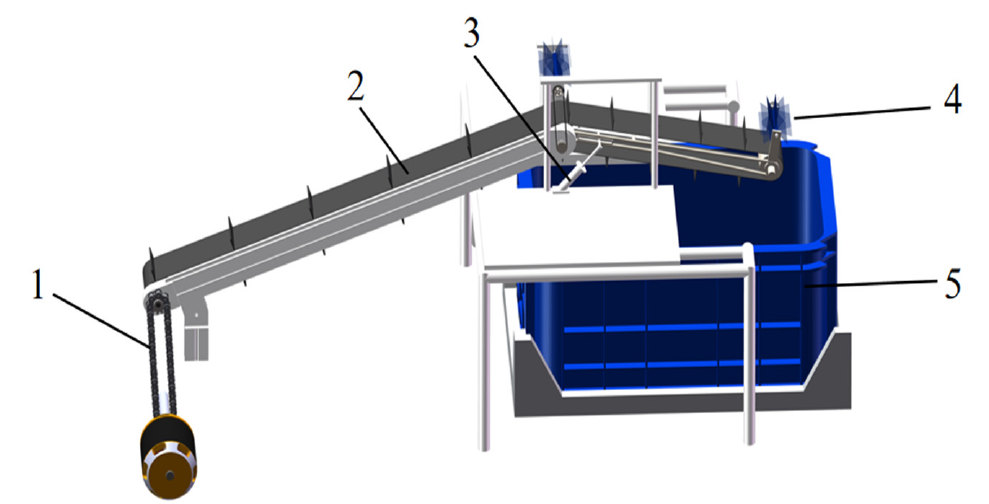
Figure 5. The conveying and collecting mechanism. 1. Roller drive source 2. Conveyor belt 3. Electric cylinder 4. Roller brush 5. Collection box.